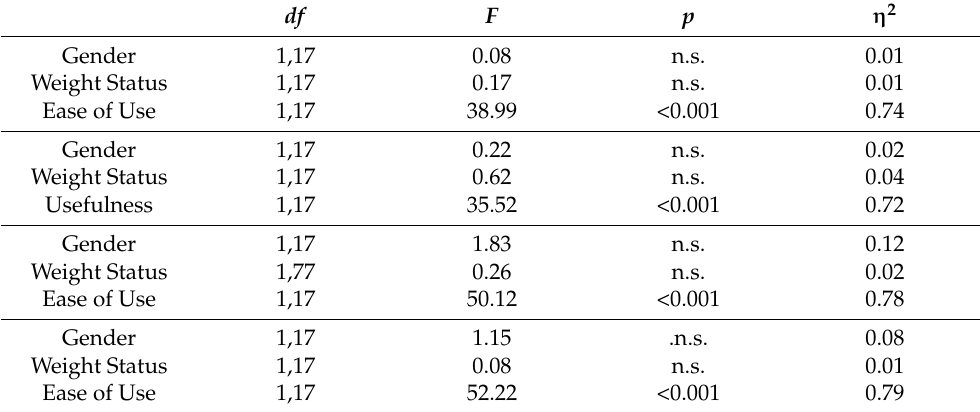
Table 2. Two-way ANCOVA results for perceived health message